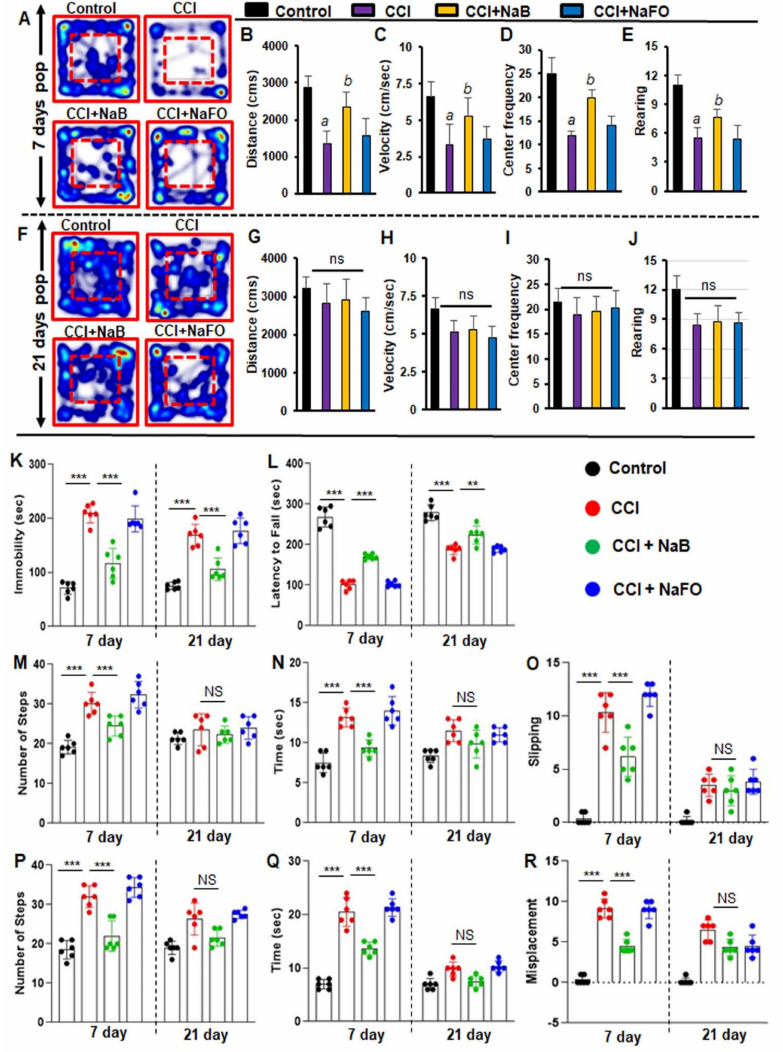
Figure 5. NaB treatment improves motor functions in mice with CCI injury. Mice were orally treated with 50 mg/kg/day of NaB or NaFO from 24 h after the induction of CCI injury. After 7 days of treatment, mice were tested for open field behavior: ( A ) Heat map analysis was performed by using the Noldus behavioral program; ( B ) distance moved; ( C ) velocity; ( D ) center frequency; and ( E ) rearing behavior. Statistical analyses were conducted with the Student t -test for distance moved ( a p < 0.001 (=0.0001) vs. control; b p < 0.001 (=0.0029) vs. CCI injury); velocity ( a p < 0.001 (=0.0001) vs. control; b p < 0.001 (=0.0078) vs. CCI injury); center frequency ( a p < 0.001 (=0.0001) vs. control; b p < 0.001 (=0.0036) vs. CCI injury); and rearing behavior ( a p < 0.001 (=9.498 × 10 − 6 ) vs. control; b p < 0.001 (=0.0081) vs. CCI injury). However, there was no significant improvement noticed in the heat map ( F ) between treated and untreated groups of mice by the 21 days post-injury period in ( G ) distance moved, ( H ) velocity, ( I ) center frequency and ( J ) rearing behavior. Statistical analyses were performed with two-way ANOVA and are expressed as mean ± SD for comparing the recovery of motor functions in brain-injured mice after NaB treatment. ( K ) Following NaB treatment, mice with CCI injury showed significant improvement in the tail suspension test [F 3,20 = 198.3 35.84 ( p < 0.0001)] control vs. CCI injury and [F 1, 20 = 35.85 ( p < 0.001)] CCI injury vs. CCI injury plus NaB treatment post-injury. ( L ) The performance of mice with NaB treatment significantly improved in the rotarod test [F 1,20 = 168.10 (*** p < 0.0001)] control vs. CCI injury and [F 3,20 = 197.40 (*** p < 0.0001)] CCI injury vs. CCI injury with NaB treatment. Oral treatment of NaB also improved the performance of CCI-injured mice on the beam runway (( M ), number of steps; ( N ), time taken; ( O ), foot slipping)